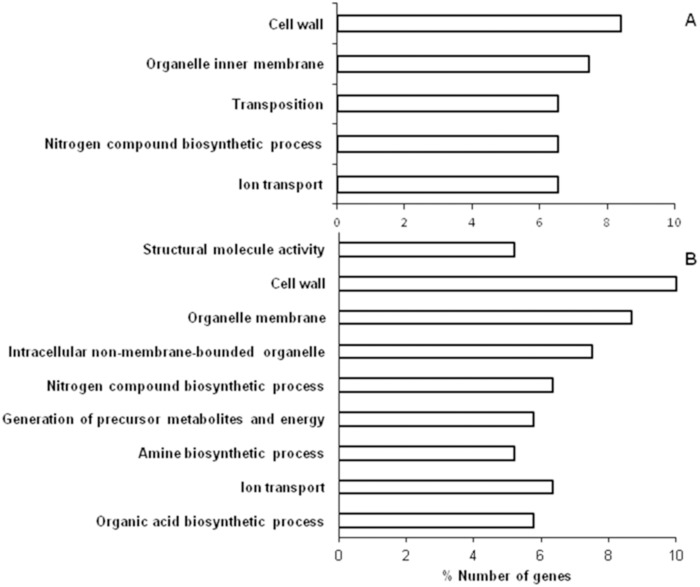
Genes up regulated (%) in E. coli LSP cells grown in LB + glycerol compared with stationary phase cells of E. coli which was sub-cultured in LB based on biological process classification reported by Gene ontology term functional categories using DAVID version 2.0 software (A).Genes down regulated (%) in E. coli LSP cells grown in LB + glycerol compared with stationary phase cells of E. coli which was sub-cultured in LB based on biological process classification reported by Gene ontology term functional categories using DAVID version 2.0 software (B).